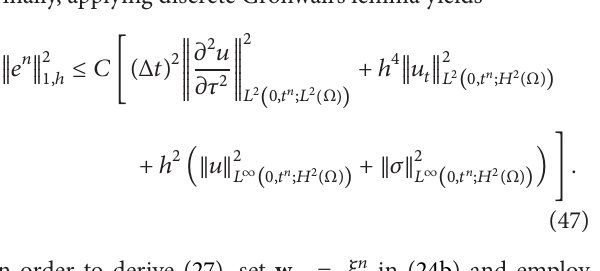
Table 1: Numerical results of ‖𝑢 − 𝑢 ℎ ‖ 1,ℎ .